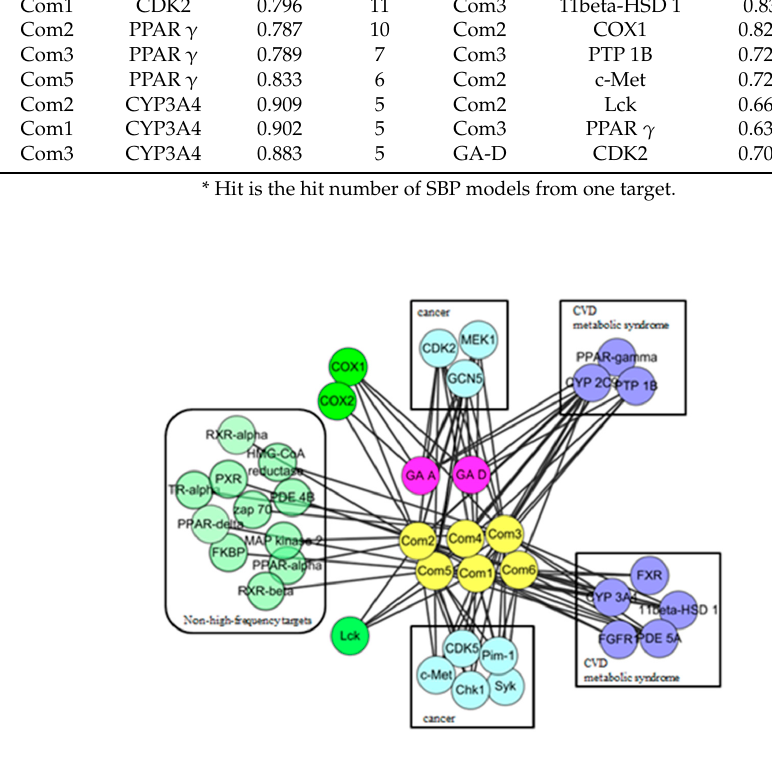
Figure 2. Ingredient ‐ target network of GTs.